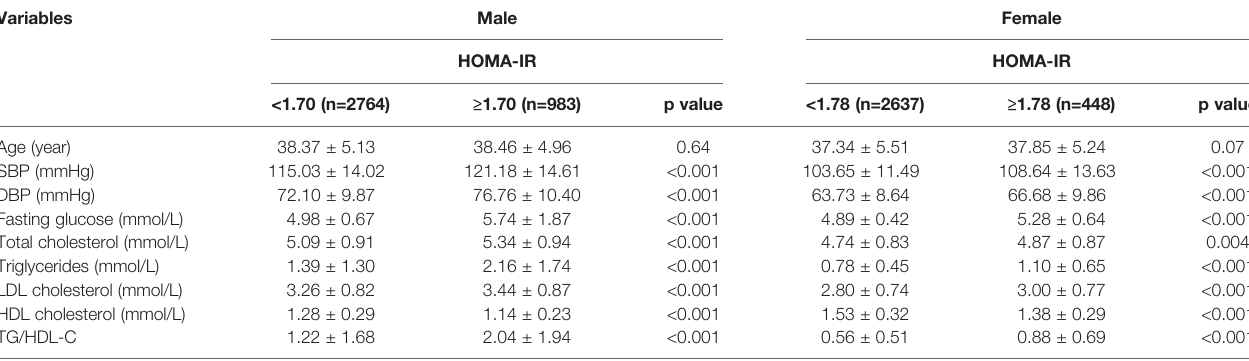
TABLE 4 | Demographic and cardiometabolic risk factors in normal waist circumstance (men<90cm, women<80cm) adults by HOMA-IR (N=6832) and gender. Variables Male